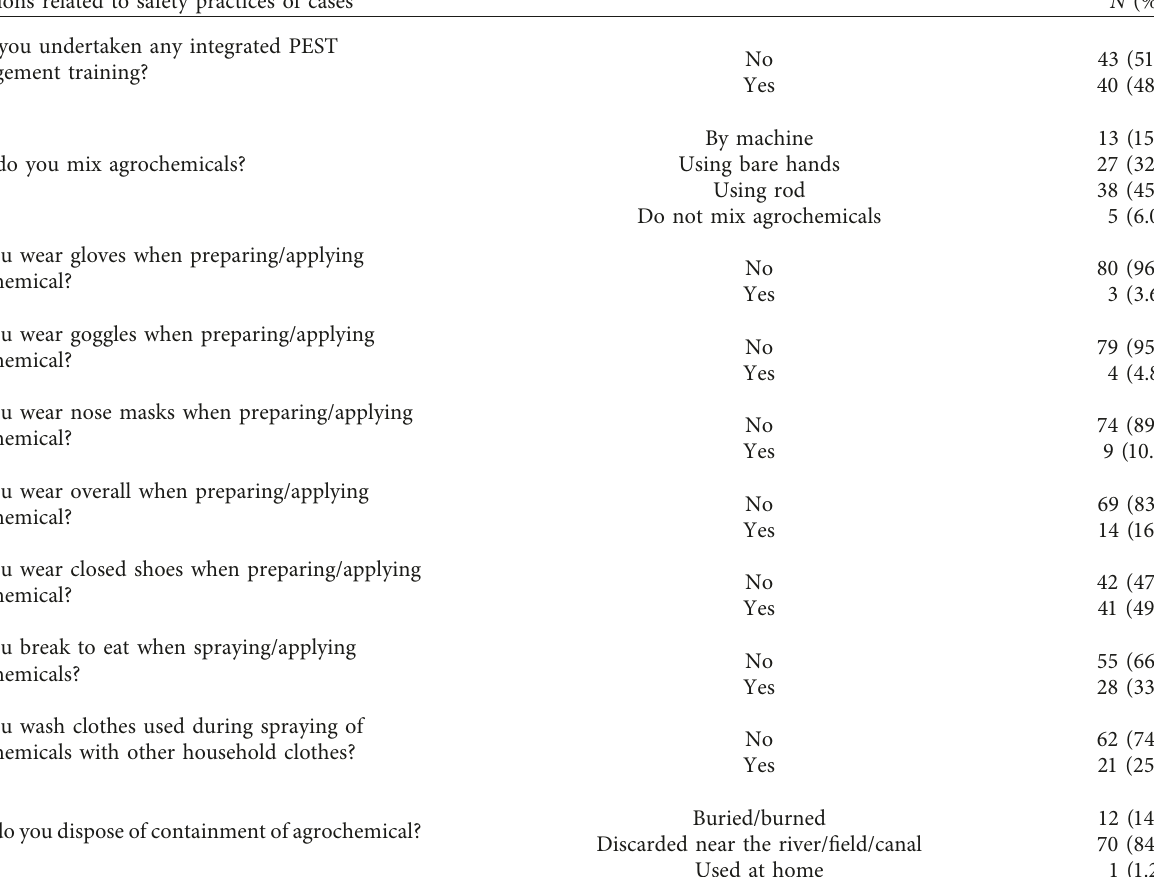
Table 5: Safety practices of